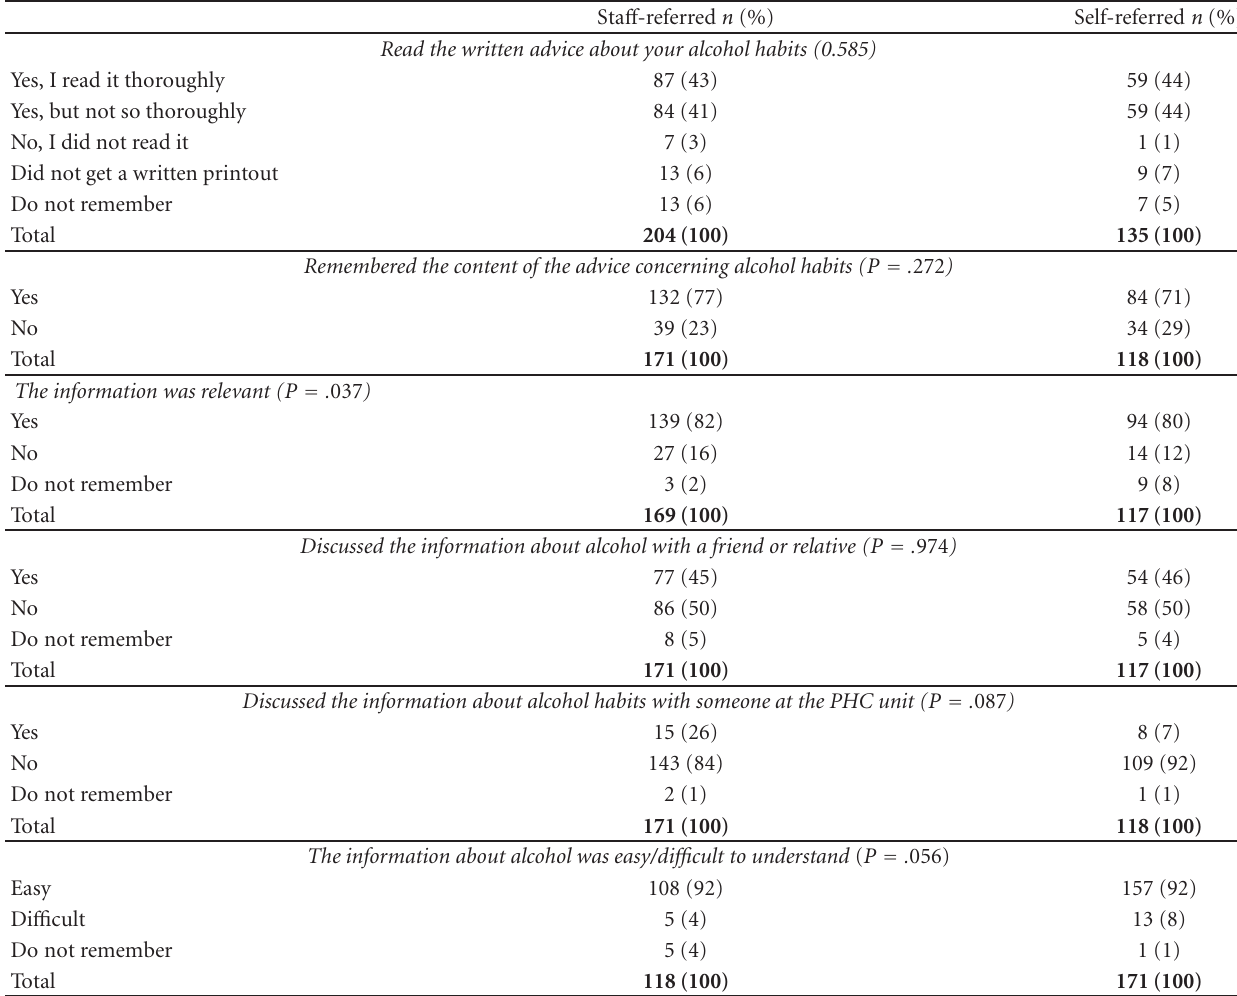
Table 4: Sta ff -referred and self-referred risky drinkers perception of the usefulness of the computerized advice comparing. Sta ff -referred n (%) Self-referred n (%) Read the written advice about your alcohol habits (0.585) 87 (43) 59 (44) 84